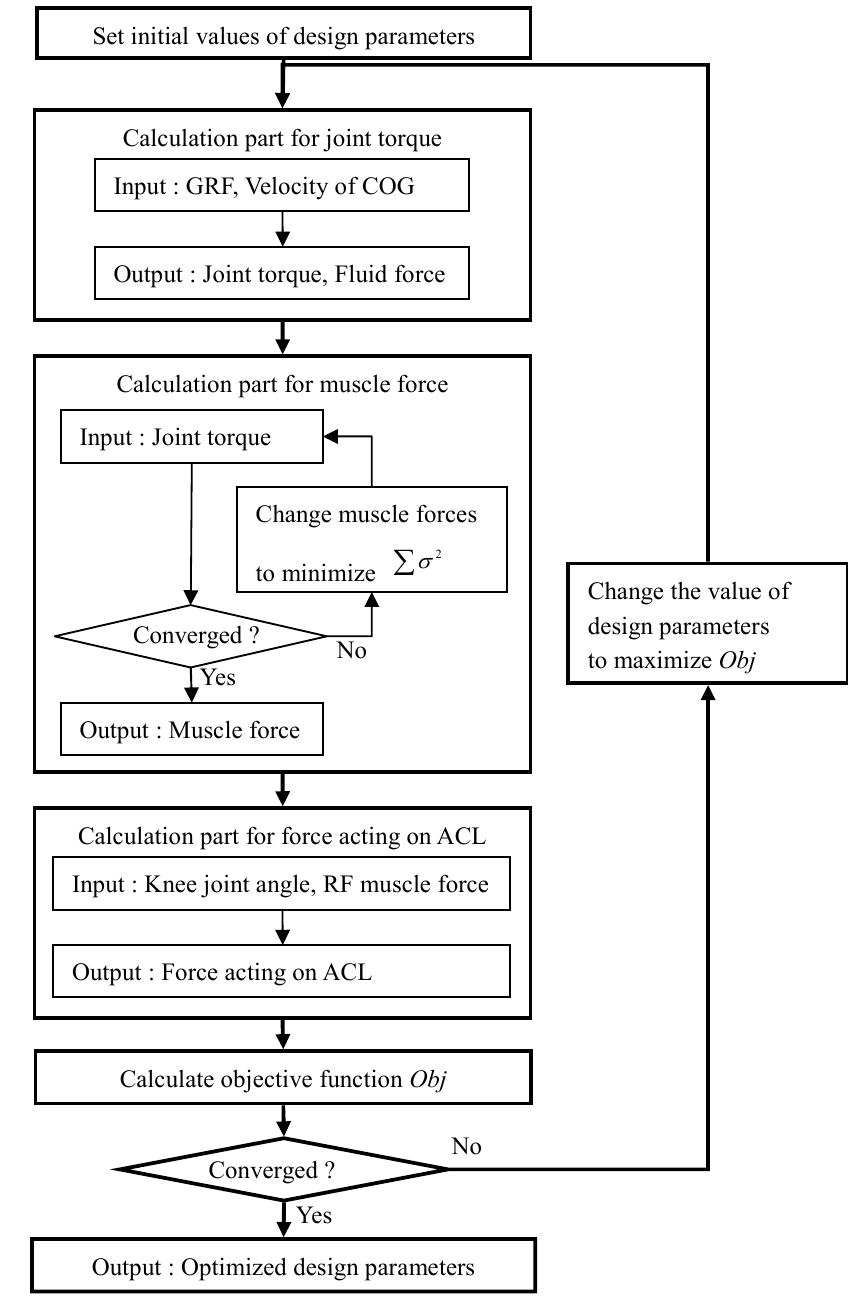
Fig. 1 Calculation flow of the simulator for optimization of walking form in